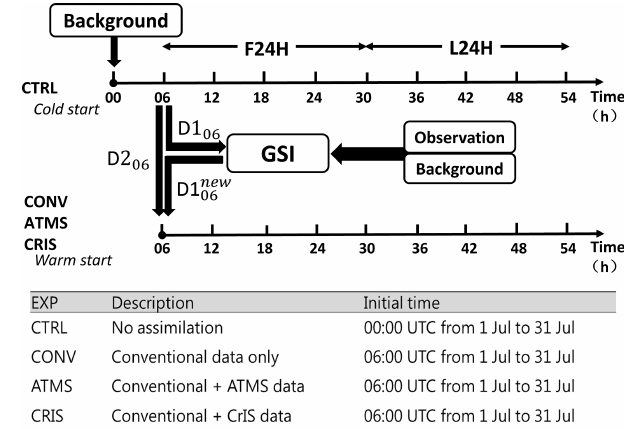
Figure 3. Top panel shows the schematic of data assimilation con- figuration with 3D-Var. Bottom panel presents the experiment de- sign. CTRL: control experiment without data assimilation for which the initial time is 00:00UTC from 1 to 31 July; CONV: data assim- ilation with conventional data only; ATMS: data assimilation with conventional and ATMS data; CRIS: data assimilation with conven- tional and CrIS data. CONV, ATMS, and CRIS experiments all start at 06:00UTC from 1 to 31